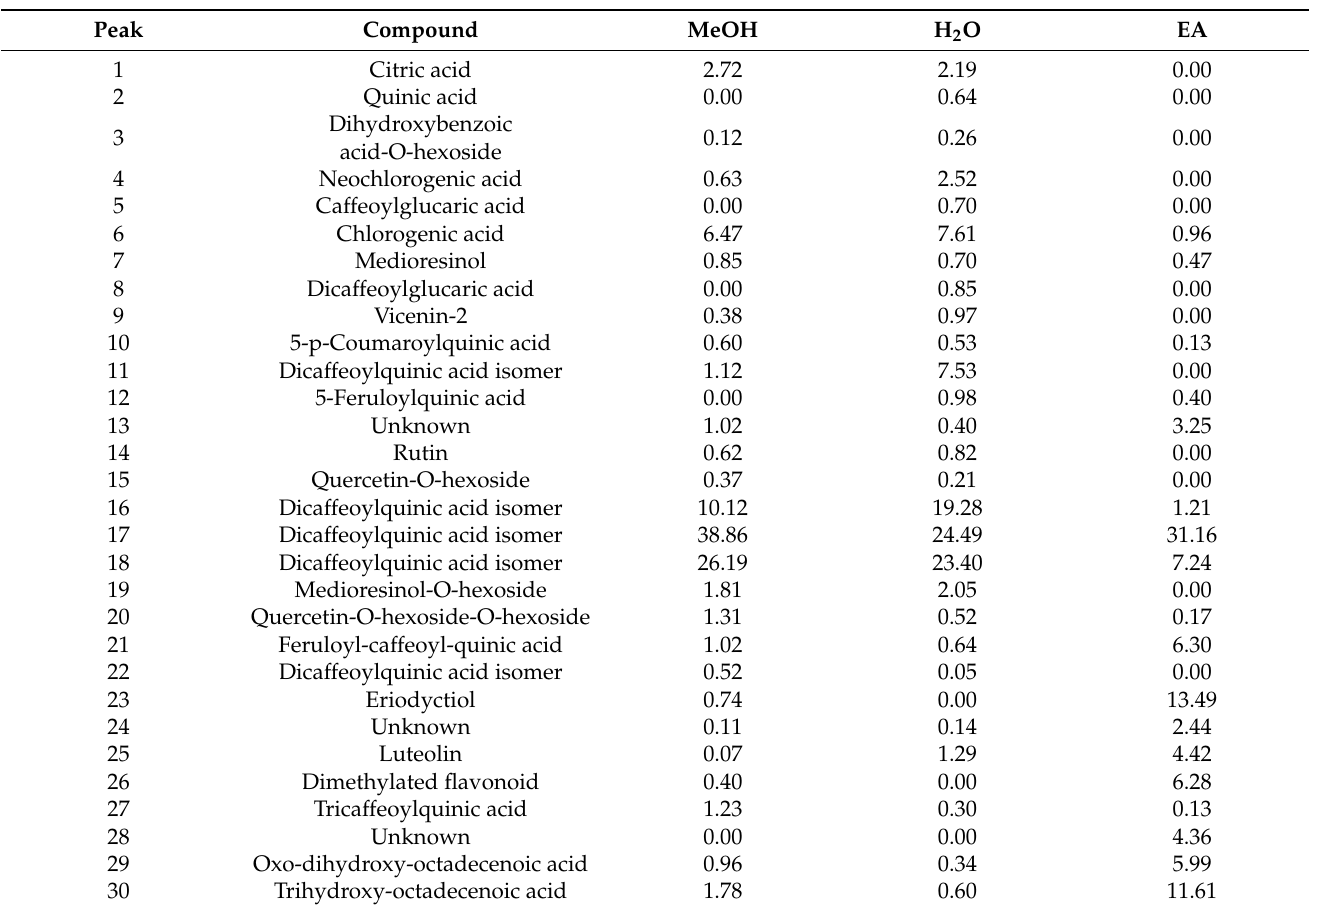
Table 4. Relative peak areas and heat map of extracts of Artemisia verlotiorum